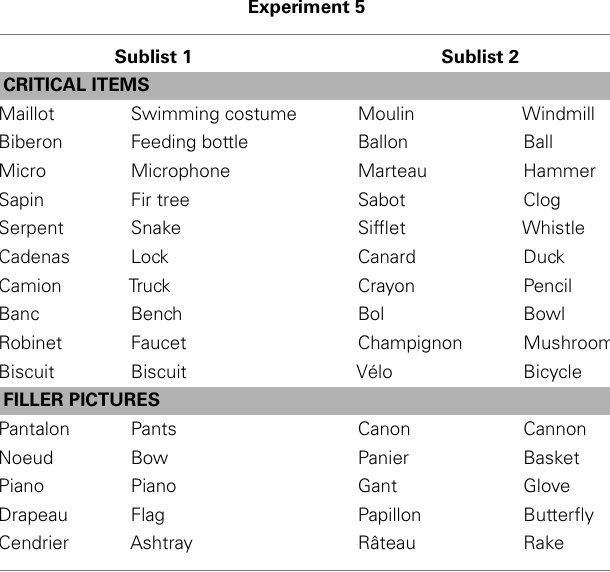
The filler items were the 25 filler masculine nouns and the 25 filler verbs used in Experiments 1, 3, and